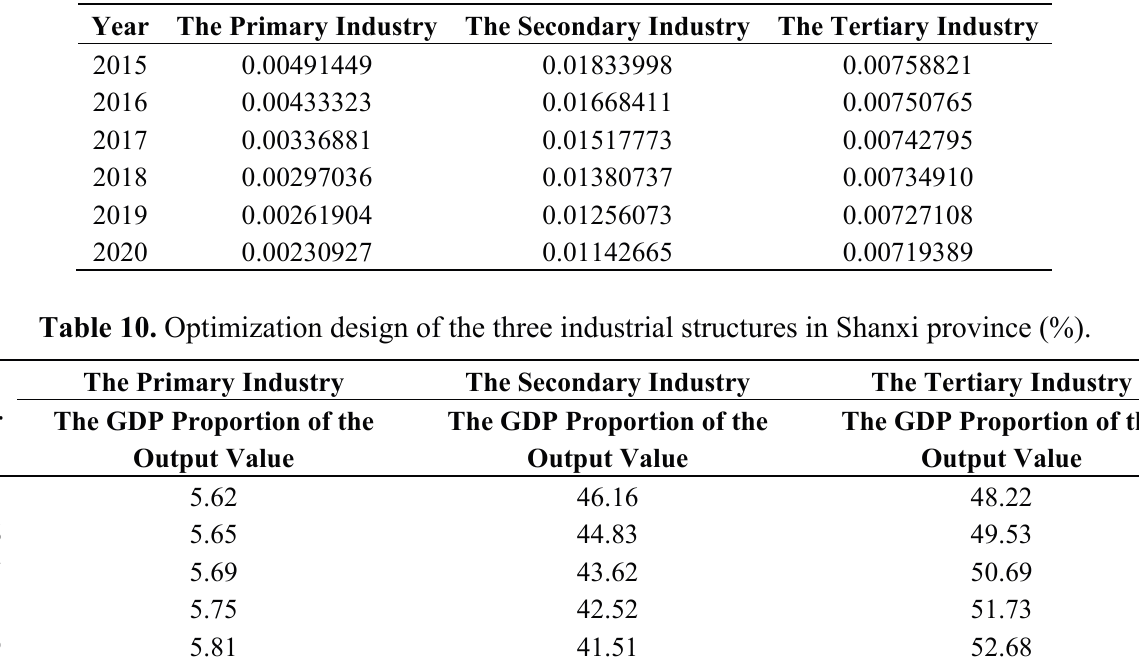
Table 9. Predicted values of the total CO 2 emissions in 100 million yuan (100 million tons).